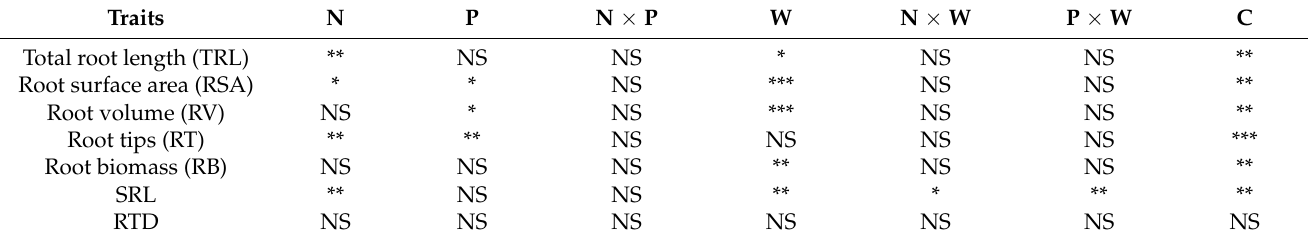
Table 3. The analysis of variance of the effects of nitrogen addition (N), phosphorus addition (P) and water addition (W) and their interactions (N × P, N × W and P × W), in addition to fragment size (C), on seven root traits for Stipa breviflora